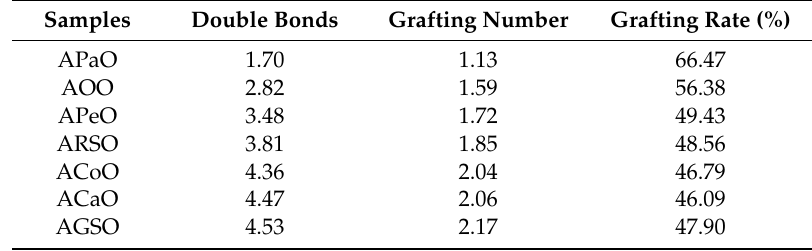
Table 1. Grafting number and grafting rate of di ff erent vegetable oil-based acrylate prepolymers.